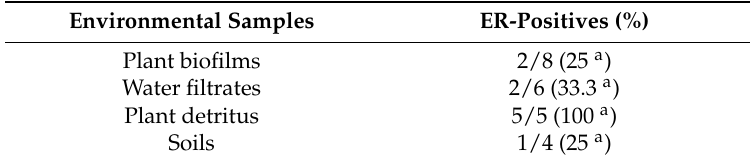
Table 4. Distribution of ER-positive mycolactone producing mycobacteria in aquatic environmental matrices from